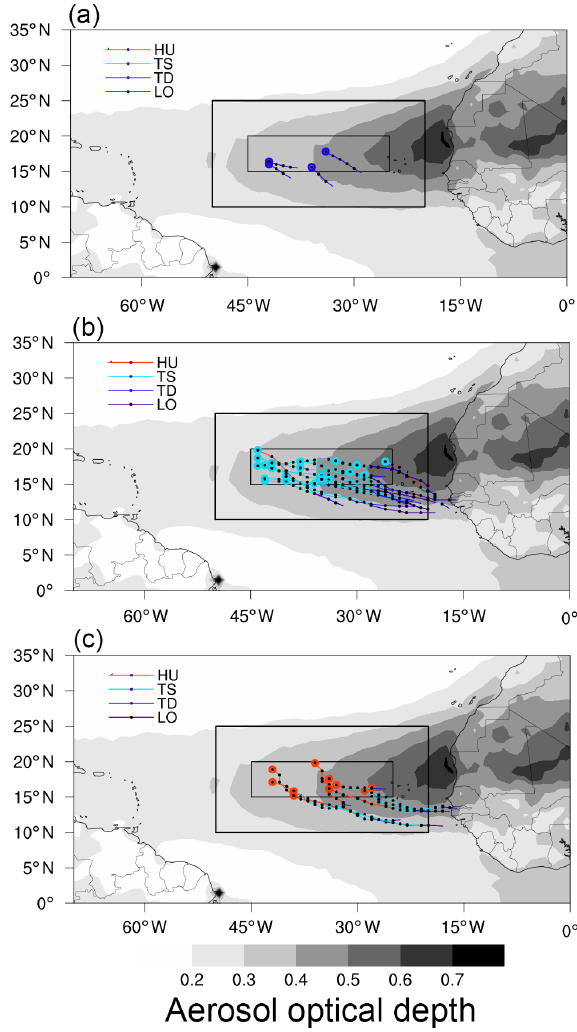
Figure 4. The tracks of the TCs. (a) TD, (b) TS, and (c) HU un- der polluted conditions. The blue, green, and red dots represent the centers of the studied TD, TS, and HU, respectively. The black dots are the TC centers every 6h before. The contour map is the spa- tial distribution of the average AOD from July to September during